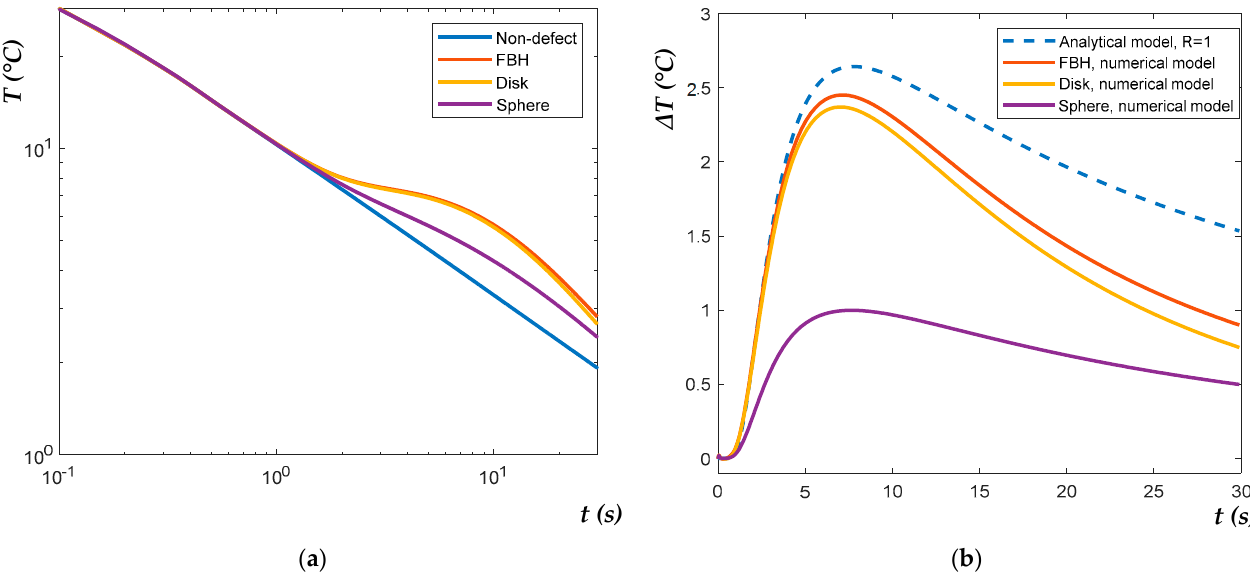
Figure 6. Temperature evolutions in logarithmic scale ( a ) and temperature contrasts Δ T ( b ) for FBH, disk and sphere ( D = 3 mm and d = 0.6 mm) obtained by numerical modelling.